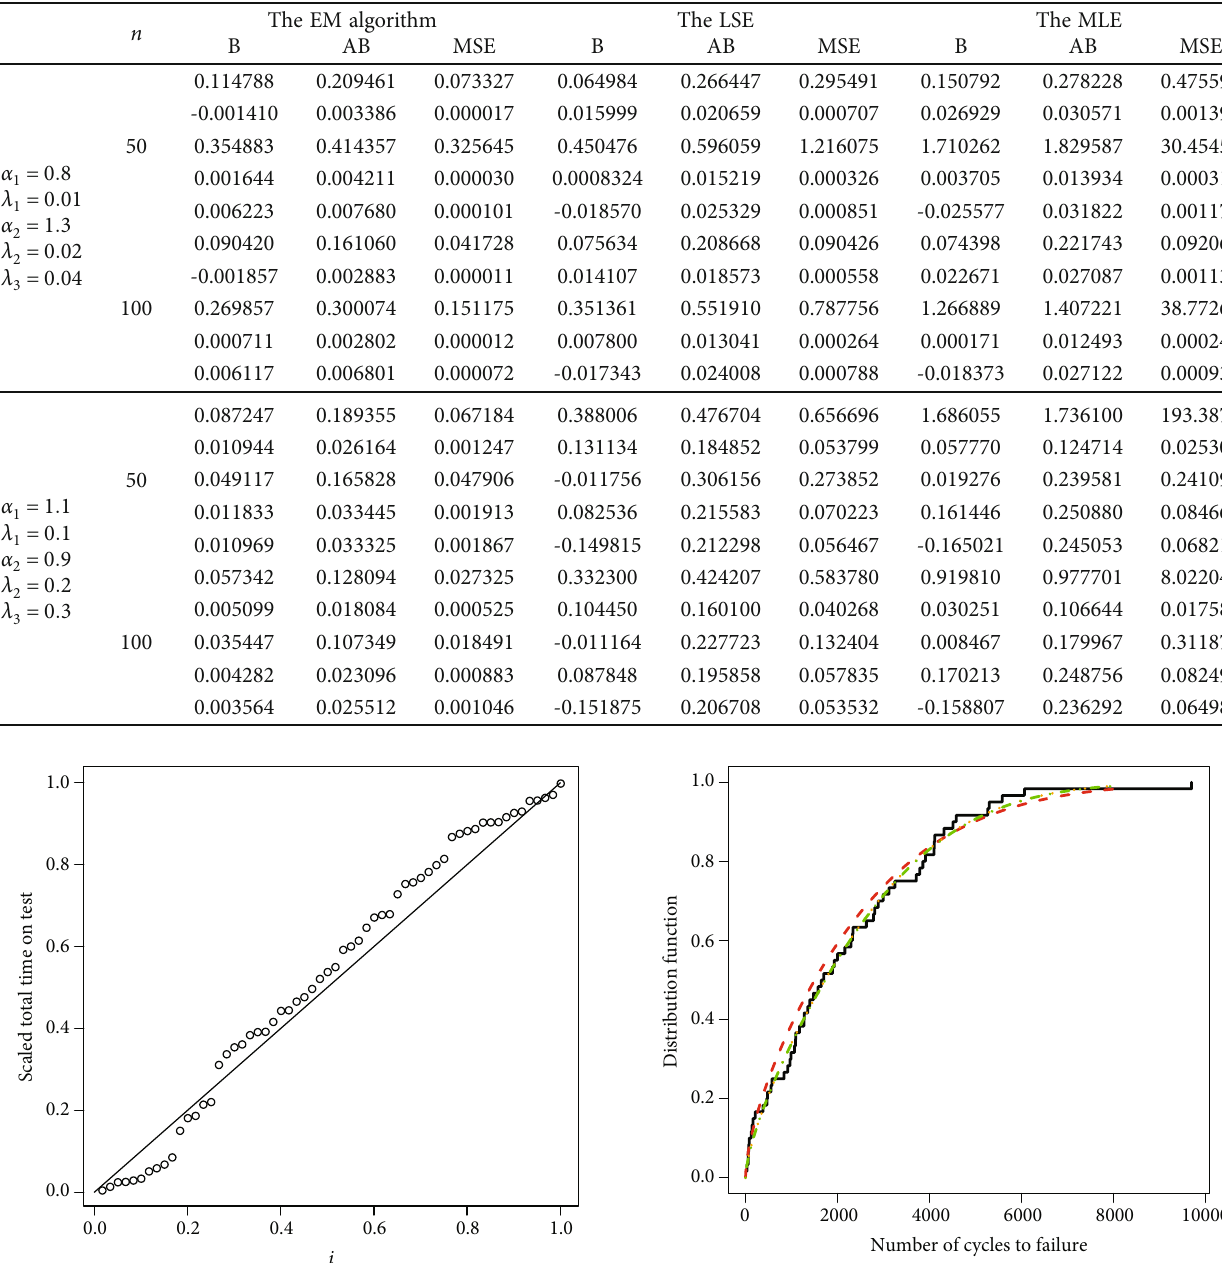
Table 1: Every cell consists of the bias, the absolute bias, and the mean squared error for fi ve parameters α bottom, respectively.